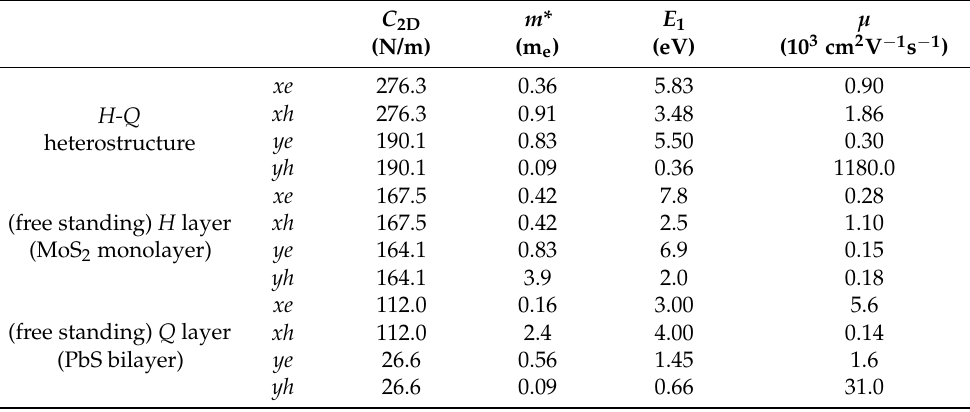
Figure 3. Calculated electron (e) and hole (h) mobilities of the 2D MoS 2 -PbS heterostructure and the free-standing PbS and MoS 2 monolayers. Table 2. Calculated in-plain stiffness (C 2D ), effective mass ( m *), deformation potential ( E 1 ), and mobility ( µ ) of 2D MoS 2 -PbS heterostructure and (free-standing) constituent layers;) and xh ( yh ), respectively, are electrons and holes along x-direction